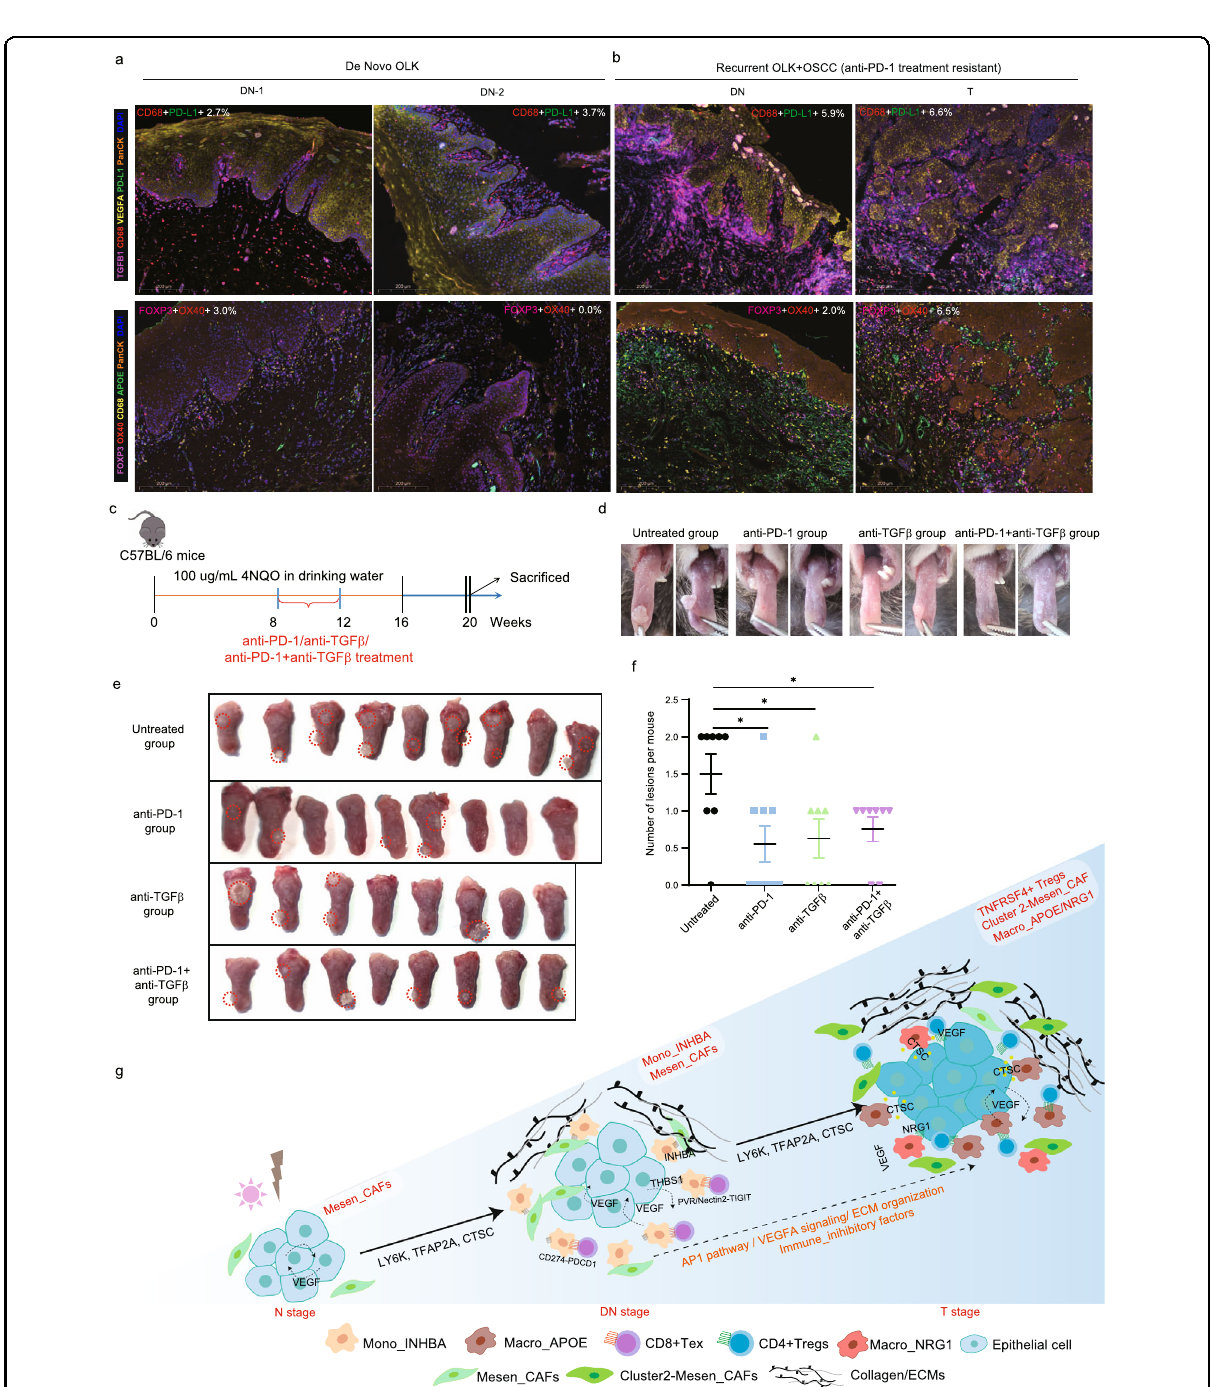
Fig. 7 mIHC staining showing clinical relevance and cellular crosstalk landscape for OSCC initiation. a , b mIHC staining of two groups of selected markers (Group 1: PD-L1, TGF β 1, VEGFA, CD68, and PanCK; Group 2: APOE, CD68, FOXP3, OX40, and PanCK) in the samples of de novo OLK ( a ) and recurrent OSCC with OLK ( b ). Those recurrent OSCC samples with recurrent OLK were taken from patients who had OLK-derived OSCC before. The patients were under a clinical trial focusing on anti-PD-1 antibody treatment. Scale bars: 200 μ m. Statistical quanti fi cation is shown in each image. c Flowchart showing the induction of OSCC by 4NQO in C57BL/6 mice and intraperitoneal injection of anti-PD-1/anti-TGF β /anti-PD-1 + anti-TGF β antibody in each treatment group. d Representative intraoral lesions on the tongues of mice in each group. e Macroscopic lesions on the tongues of each group. The dotted circle indicates cauli fl ower-like lesions. f Statistical results for quanti fi cation of the macroscopic cauli fl ower-like lesions in each treated and untreated group. A two-tailed Student ’ s t- test for the P values. * P < 0.05. g Potential maps on malignant transformation of epithelial cells and dynamic crosstalk between epithelial cells and the TMEs during OSCC